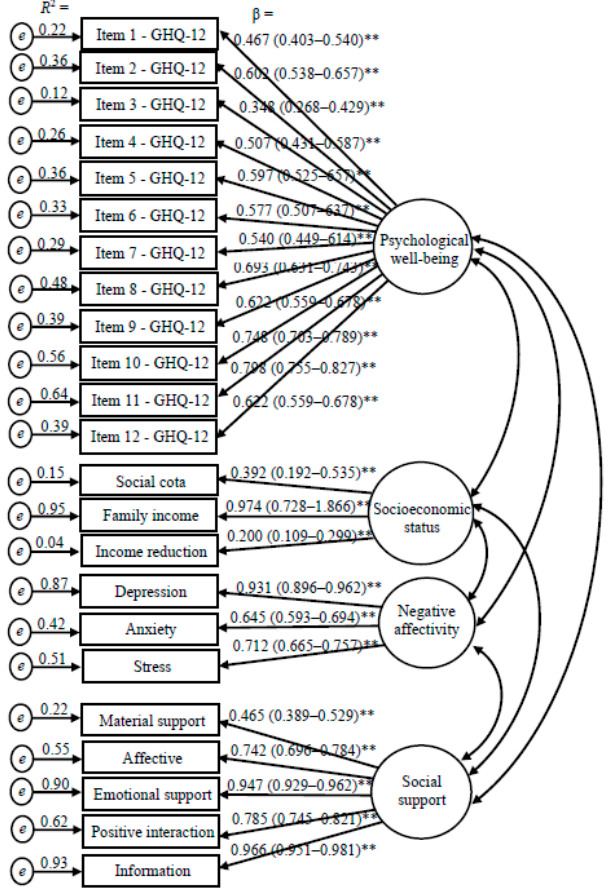
Figure 2. Confirmatory factor analysis of the four-factor and twenty-three-item measurement model